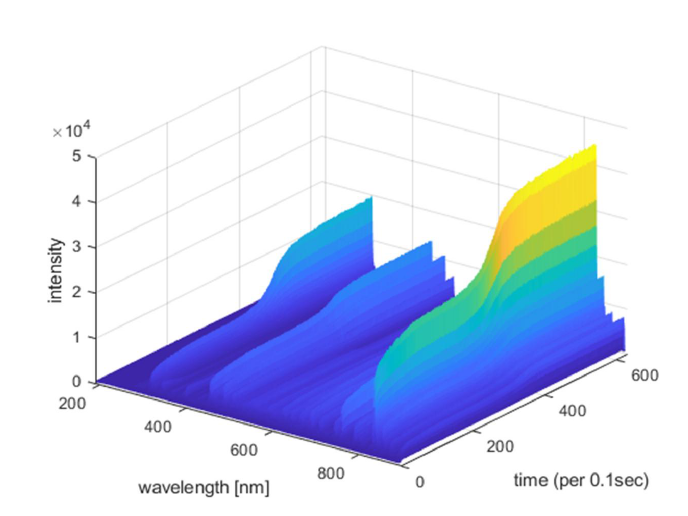
Figure 4. A 3-D plot of a sample of actual OES spectrum